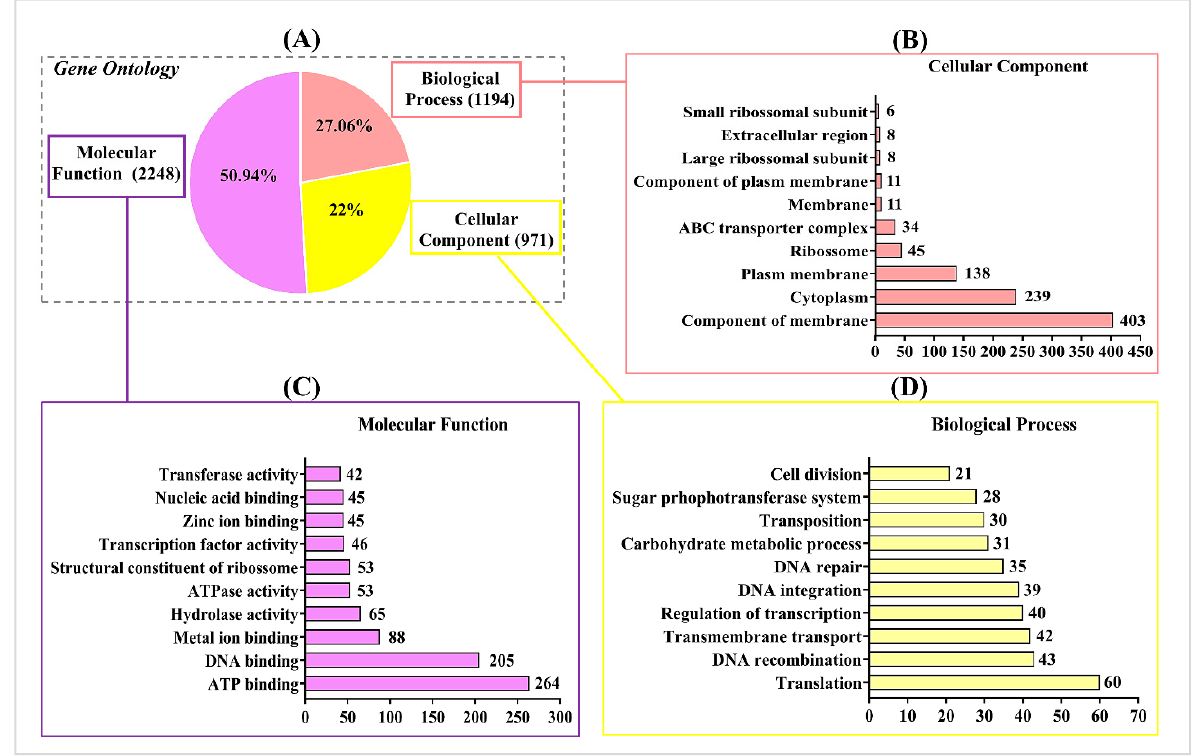
Figure 2. Distribution of Lactobacillus delbrueckii subsp. lactis CIDCA 133 (CIDCA 133) genes among the Gene Ontology (GO) categories predicted in Gene Ontology Functional Enrichment Annotation Tool (GO FEAT) ( A ). The genes were distributed in Cellular component ( B ), Molecular function ( C ), and Biological process ( D ) categories.